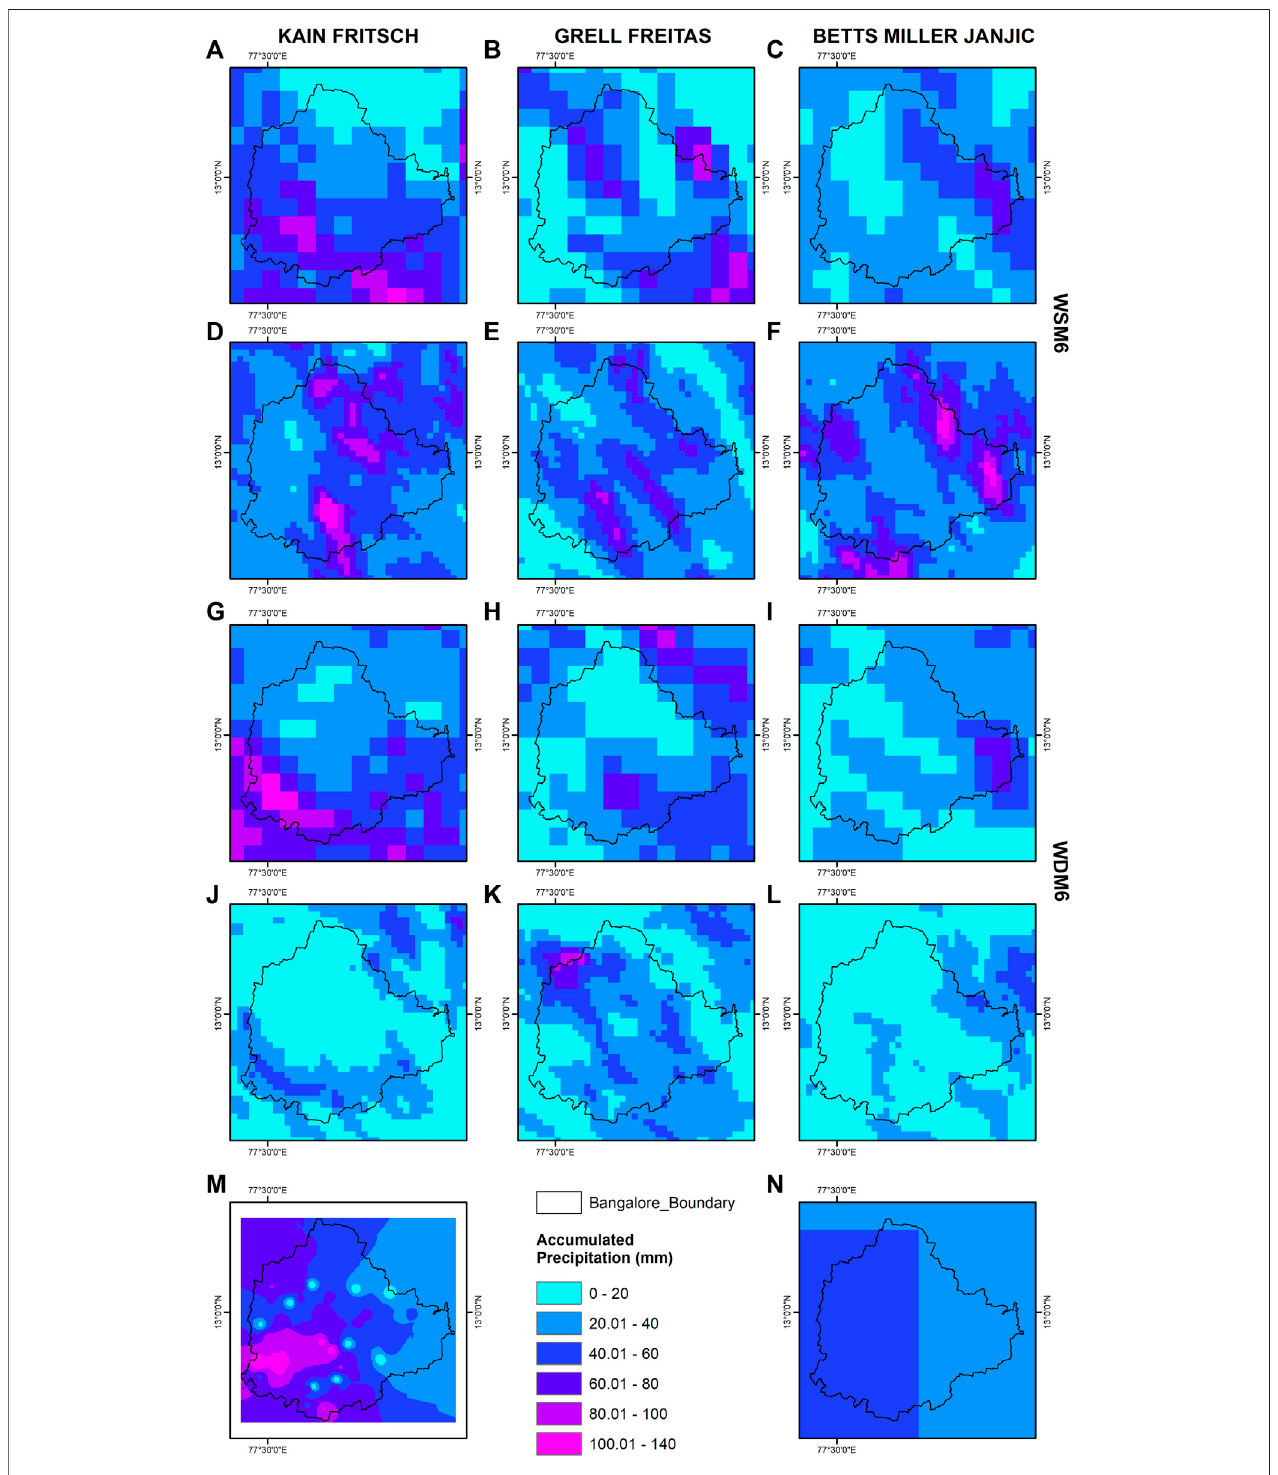
FIGURE 3 | Spatial distribution of 24 h accumulated rainfall (mm) from WRF ensemble, Global Forecast System (GFS) data and observed rainfall. (A – N) , Spatial distribution of 24 h accumulated rainfall (mm) from WRF ensemble simulations WSM6KF3 (A) , WSM6GF3 (B) , WSM6BMJ3 (C) , WSM6KF1 (D) , WSM6GF1 (E) , WSM6BMJ1 (F) , WDM6KF3 (G) , WDM6GF3 (H) , WDM6BMJ3 (I) , WDM6KF1 (J) , WDM6GF1 (K) , WDM6BMJ1 (L) , the Global Forecast System (GFS) data (N) , and observed (M) , over the Bangalore city for the period 0300 UTC 20 October to 0300 UTC 21 October 2020. The heavy rainfall quantities ( > 60 mm/day) is well represented by theWRF ensemble and itcan be seen from (A – L) that the extreme rainfall pattern is re fl ected inthe WRF ensemble outputas compared to theGFS. The threecolumnscorrespondtothethreeconvectiveparameterizationschemesselectedforthestudy — KainFritsch,GrellFreitas,andBettsMillerJanjic.The fi rsttworows show the results from WSM6 microphysics schemes and the next two rows present the results from WDM6.